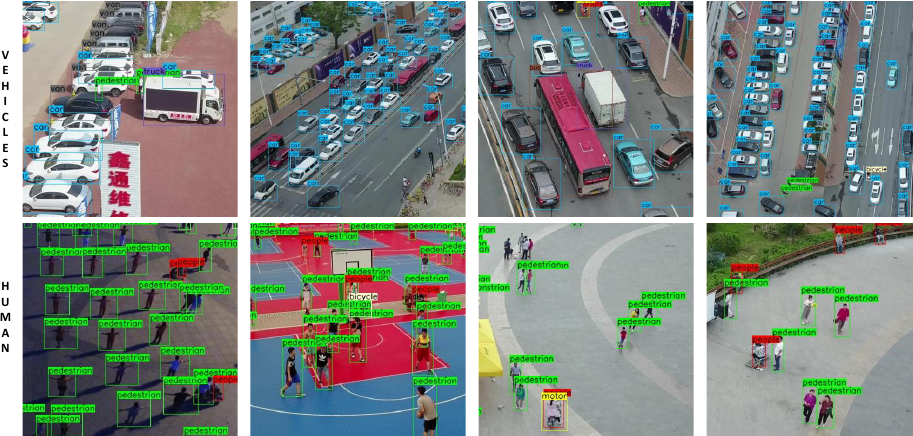
Figure 6. Some images in Visdrone2018 dataset. The angle, scale and illumination changes, and dense small objects in this dataset make high-precision object detection very